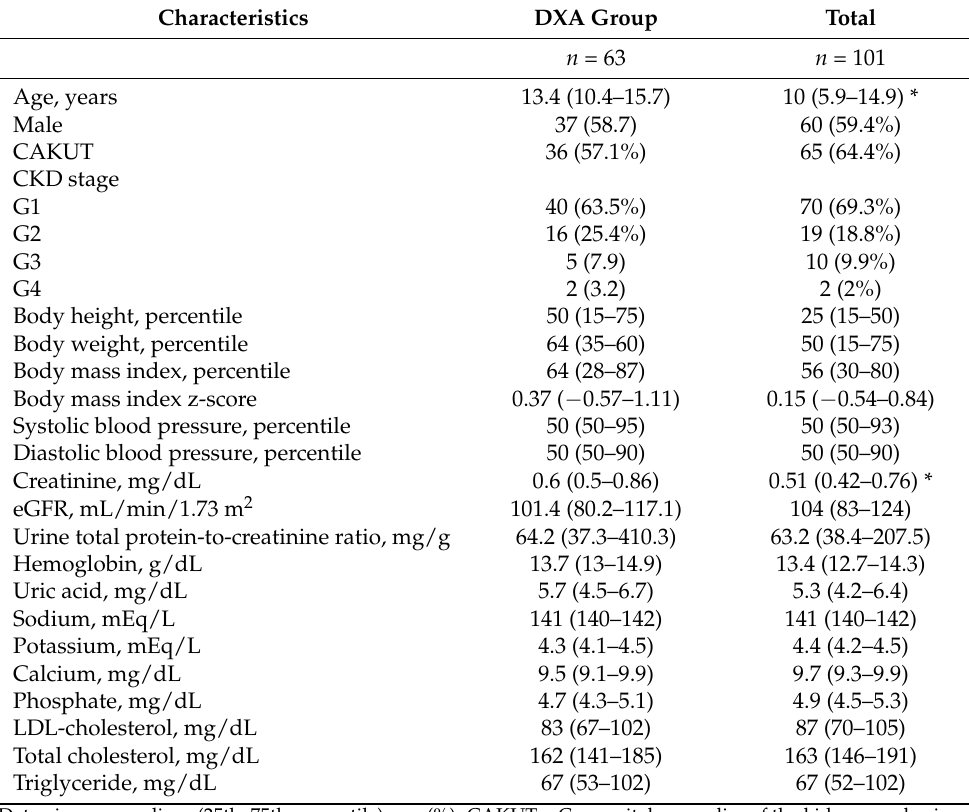
Table 1. Clinical, biomedical, and anthropometric characteristics of study